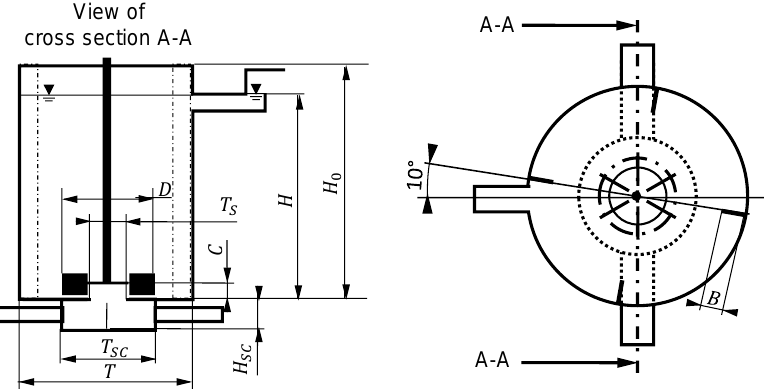
Figure 2. Geometry of the DN300 pump-mixer in accordance with the General Mills design. The suction orifice has a diameter of 𝑇 𝑆 = 𝑇/4 = 75 mm and a thickness of 4 mm. The suction chamber beneath the orifice has a diameter of 𝑇 𝑆𝐶 = 200 mm and a suction chamber height of 𝐻 𝑠𝑐 = 55 mm. The tank has 4 equal-spaced baffles (4 × 90°) each with a width of 𝐵 = 𝑇 /10 = 30 mm and a thickness of 8 mm while also covering the full height 𝐻 0 of the tank. The baffles were simply clamped against the wall; hence, they were not sealed against the wall completely. It can still be assumed that there is no flow behind the baffles. Three Optical Multimode Online Probes (OMOP) [30] were used to investigate the droplet size distribution ( 𝑀𝑃 1−3 ) at different positions and the local holdup was measured in the upper half of the vessel ( 𝑀𝑃 𝐻 ) as depicted in Figure 3.